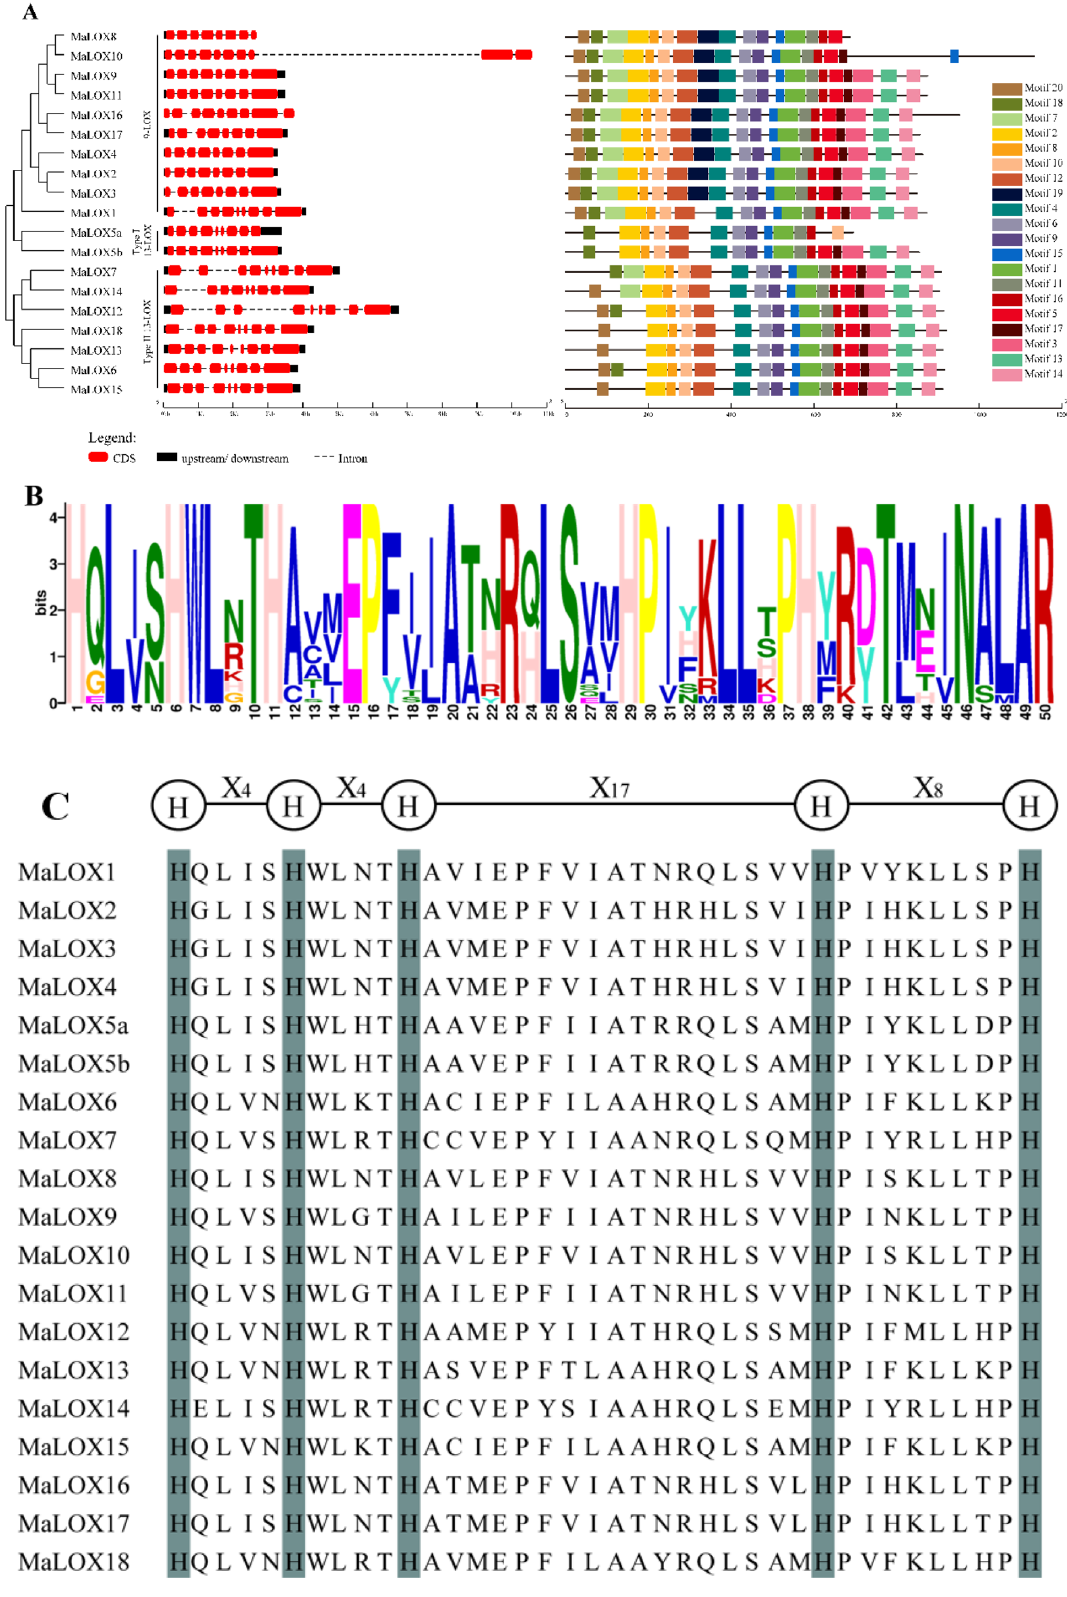
Figure 3. Gene structures and conserved motifs ( A ), Motif 1 sequence ( B ) and the 38 conserved residues of MaLOX proteins of MaLOXs or their encoded proteins. The dark color in C shows highly conserved histidine